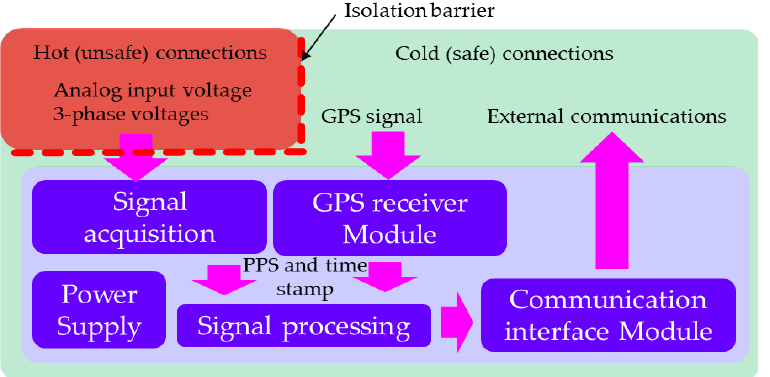
Figure 7. Block diagram of baseline PMU as implemented in [6] indicating the location of the isolation barrier.